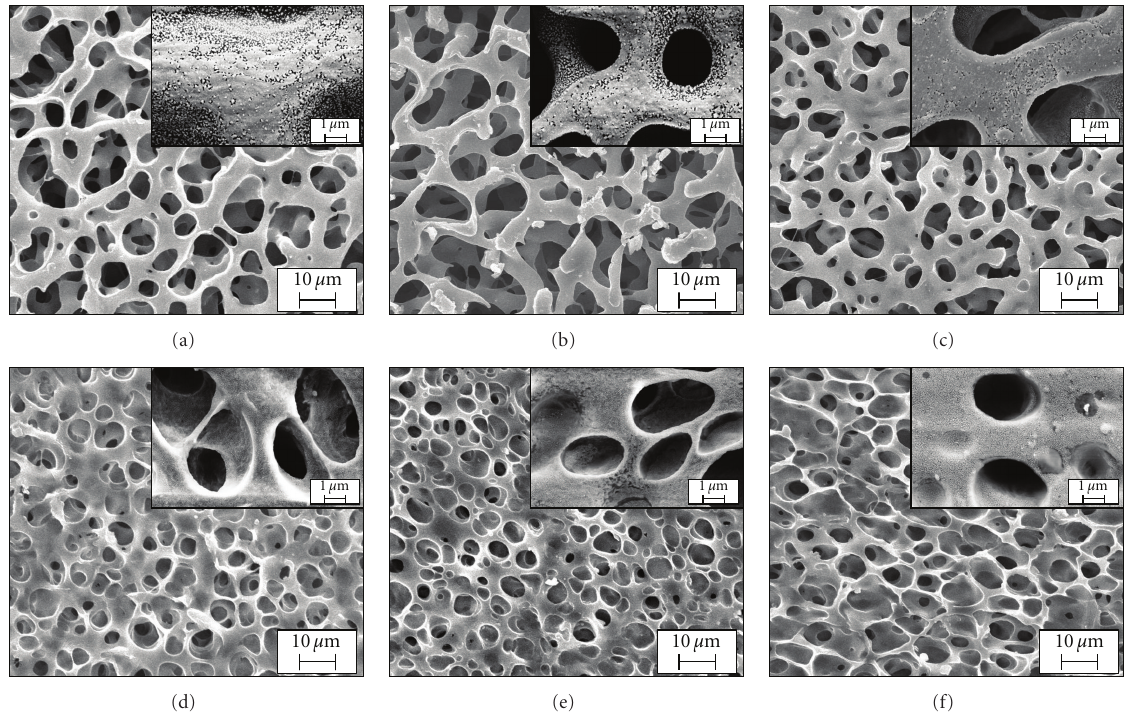
Figure 4: SEM images of polymer membranes PVDF/IL-SiO 2 (2/1). (a) the weight ratio of PVDF/IL-SiO 2 is 9/1. (b) the weight ratio of PVDF/IL-SiO 2 is 8/2. (c) the weight ratio of PVDF/IL-SiO 2 is 7/3. (d) the weight ratio of PVDF/IL-SiO 2 is 6/4. (e) the weight ratio of PVDF/IL- SiO 2 is 5/5. (f) the weight ratio of PVDF/IL-SiO 2 is 4/6.